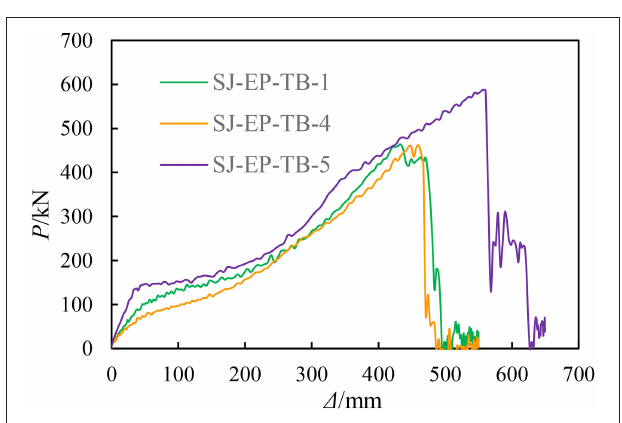
FIGURE 10 | Resistance curves comparison different thickness of extended